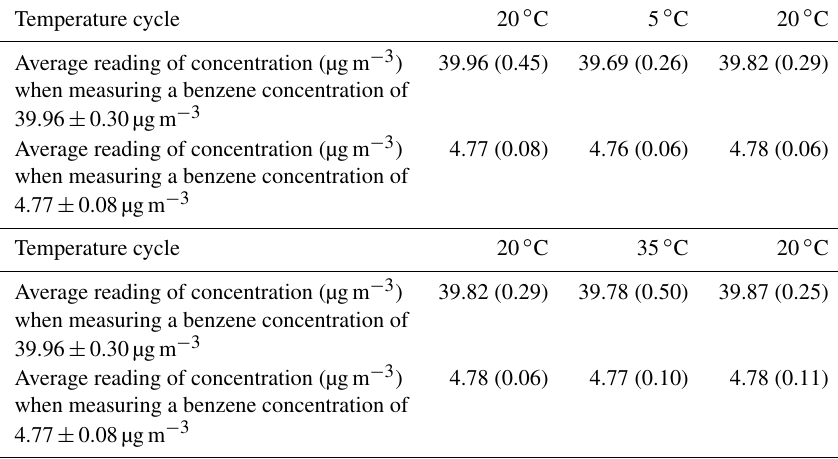
Table 1. Analyser I readings when subjected to changes in sample temperature. In parentheses, the standard deviation of the measurements.